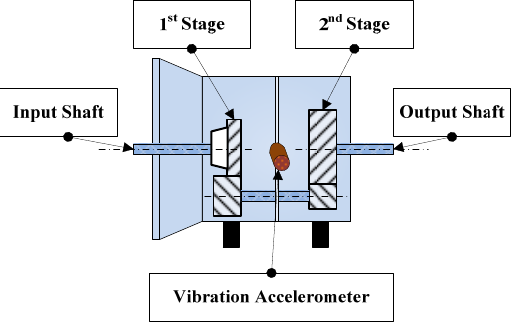
Figure 1. Schematic diagram of two ‐ stage gearbox.